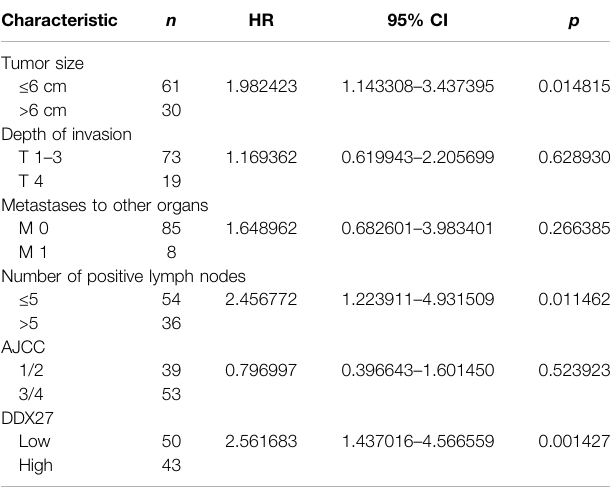
TABLE 3 | Multivariate analysis using the Cox proportional hazards